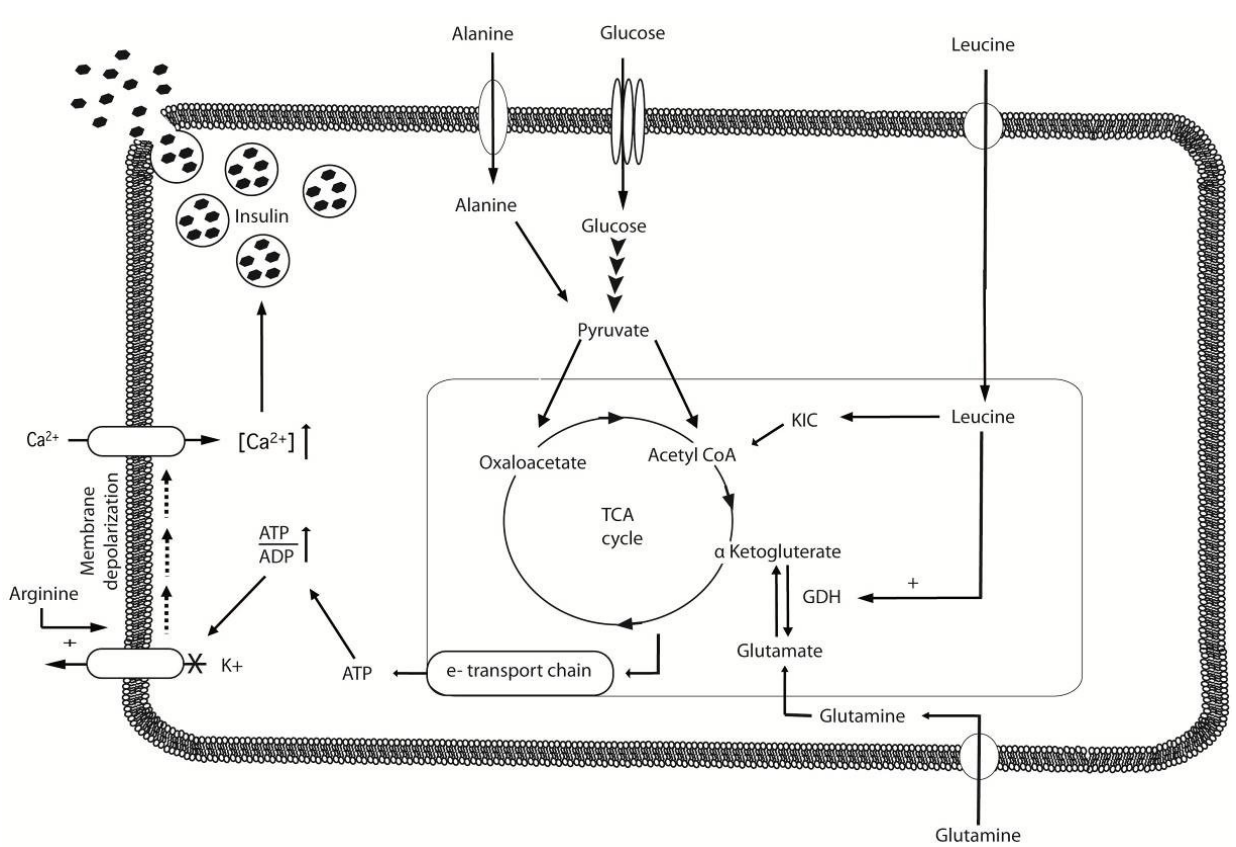
Figure 1. Simplified overview of amino acid induced insulin secretion in the β-cell. Glucose is metabolized in the cell via glycolysis into pyruvate, which is subsequently metabolized further by the tricaboxylic acid cycle (TCA cycle) to form ATP. Increased ratios of ATP/ADP result in depolarization of the plasma membrane through closure of ATP-sensitive K + channels. This depolarization opens voltage activated Ca 2+ channels, leading to increased concentrations of intracellular Ca 2+ ([Ca 2+ ] ) and subsequent insulin i exocytosis. Intracellular catabolism of all metabolizable amino acids will increase the intracellular ATP/ADP ratio, thereby closing ATP-sensitive K + channels, leading to the depolarization of the plasma membrane. Leucine both induces and enhances pancreatic β-cell insulin secretion through oxidative decarboxylation and allosteric activation of glutamate dehydrogenase (GDH) increasing ATP/ADP. Leucine can also be transaminated to α-ketoisocaproate (KIC) that is converted into acetyl-CoA before entering the TCA-cycle. Amino acids such as arginine can directly depolarize the plasma membrane of the β-cell, opening up voltage activated Ca 2+ channels leading to insulin secretion. Adapted from Newsholme et al.